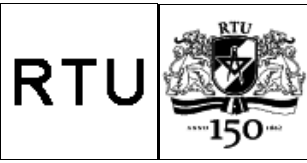
Fig. 2. Watermarks used in the experiments (90 x 90 pixels).